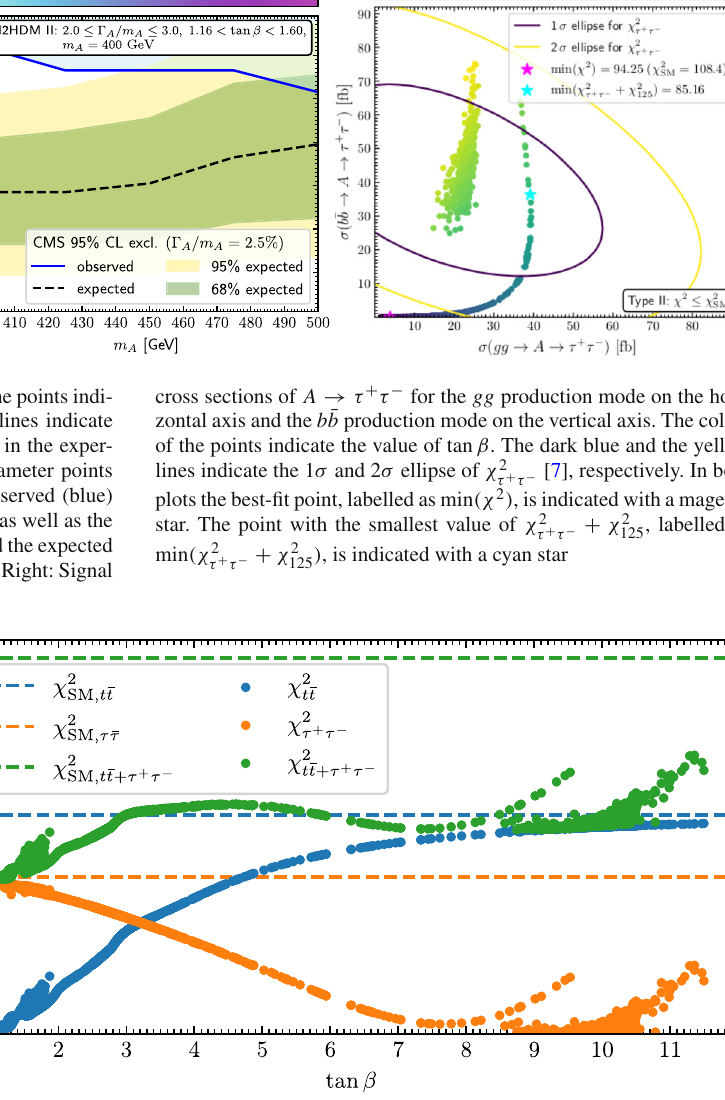
, labelled as 125